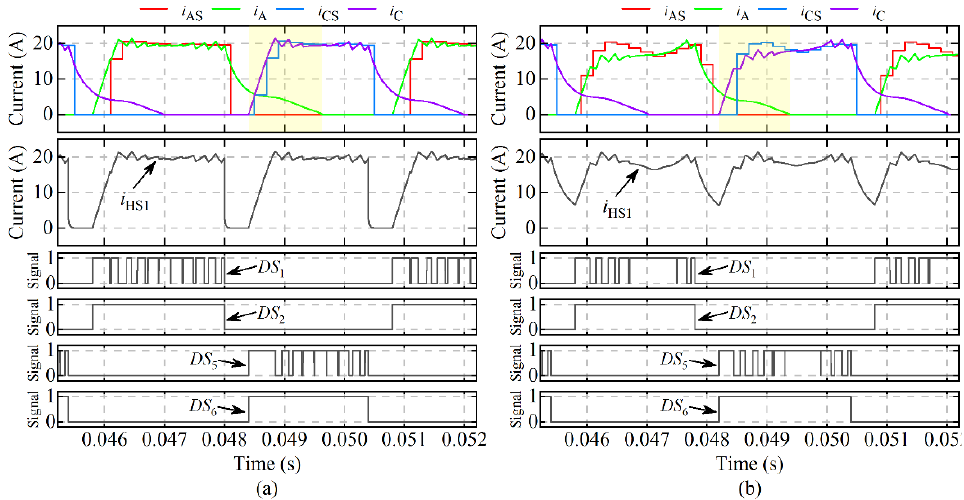
Figure 14. Simulation waveforms at 2000 rpm ( i * = 20 A). ( a ) With the proposed N p /2 sensors-based current detection scheme. ( b ) With the baseline scheme. current detection scheme. ( b ) With the baseline